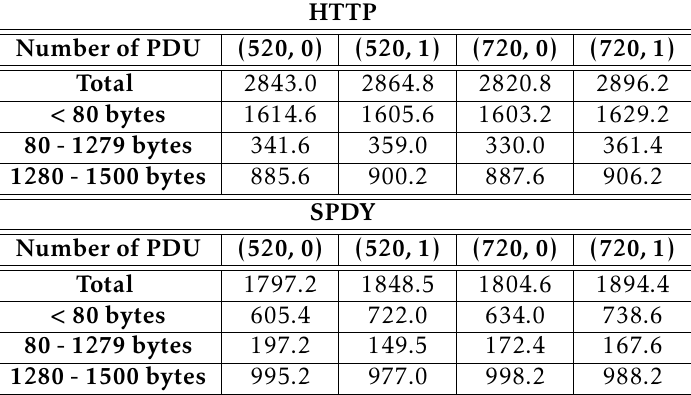
Table 3. Packet Size Analysis for Huffington Post – HTTP vs SPDY. Different trials are referred to (RTT [ms], ploss [%]).